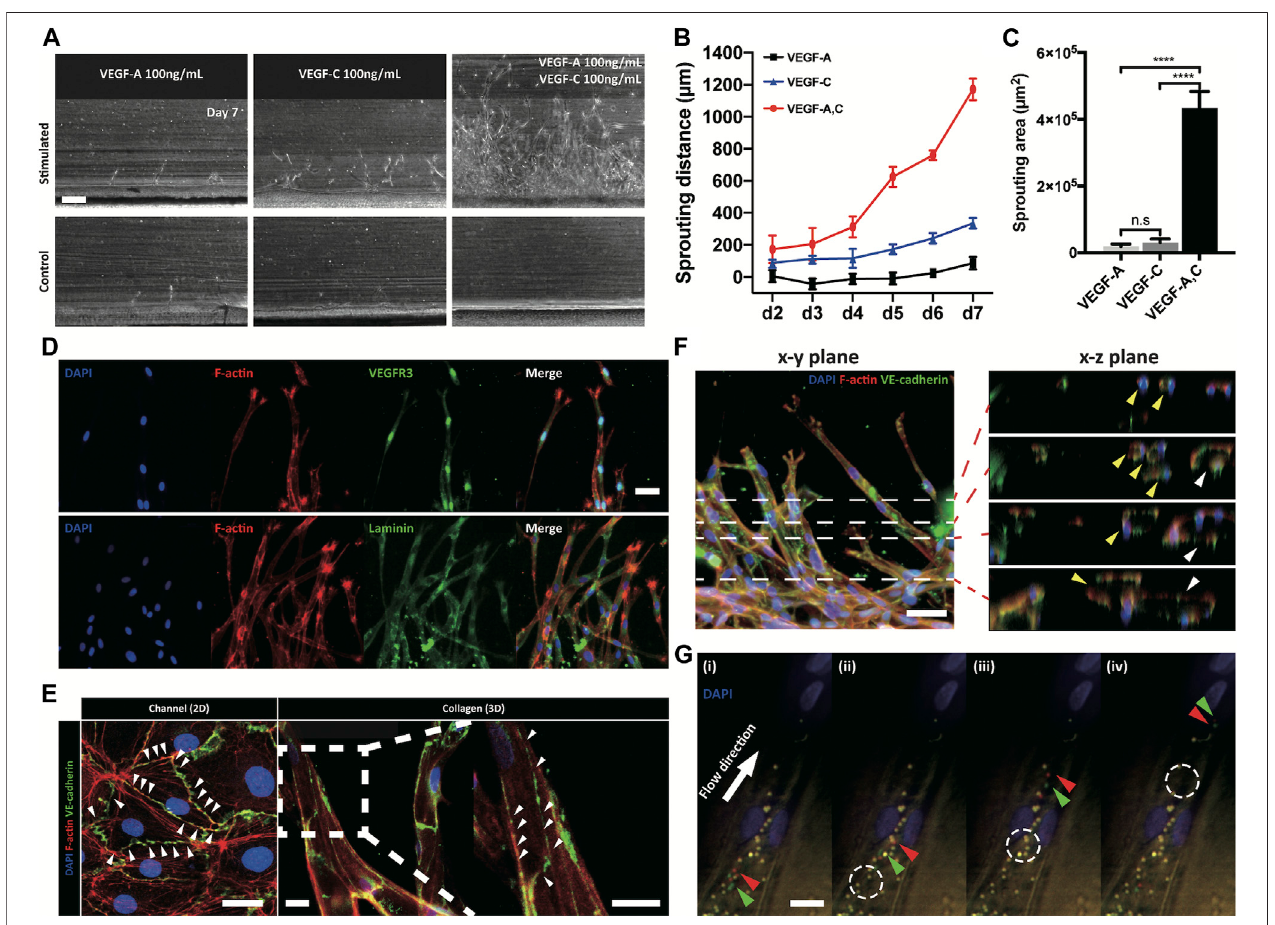
FIGURE 2 | Response of lymphatic sprouting under growth factor stimulation and characterization of generated lymphatic vessel. (A) Lymphatic sprouting under three conditions, (B) quanti fi ed sprouting distance, and (C) area in COL1. Scale bar indicates 200 μ m ( n (cid:2) 4 and error bar indicates standard deviation. *** and **** indicate p < 0.001 and p < 0.0001, respectively). (D) Lymphatic vessel expressing VEGFR3 and laminin, which indicate a lymphatic speci fi c marker and a basement membrane (scale bar 50 μ m). (E) Button-like junctional expression of a lymphatic endothelial cell and a sprouted lymphatic vessel. White arrowhead indicates discontinuouspointofthejunction.Scalebarsindicate30and100 μ minthechannel(2D)andcollagen(3D),respectively. (F,G) Luminalstructure ofsproutedlymphatic vessel using confocal microscopy. White dashed lines in the x-y plane indicate sequential images in the x-z plane, and each colored arrowhead indicates one sprouted vessel (yellow and white). Scale bar is 50 μ m. (G) Sequential images of moving microparticles in the sprouting lymphatic vessel. Green and red arrowheads indicate moving microparticles, and white dashed circle indicates previous position of moving